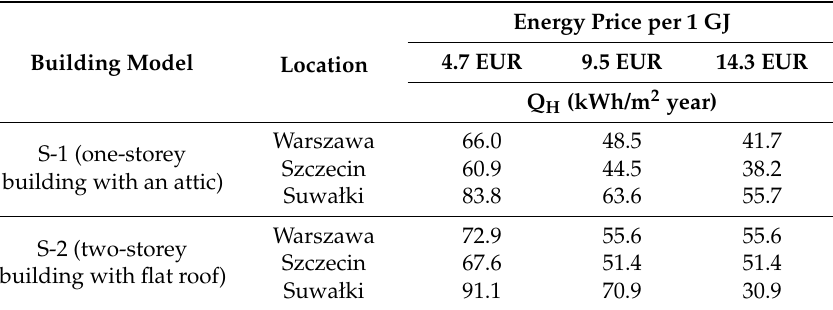
Table 18. Cost-optimum renovation